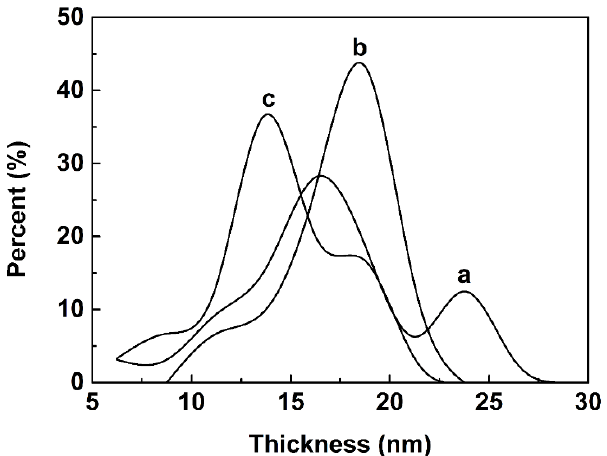
Figure 6. The thickness distribution of the Al(OH) 3 nanosheets: (a) A17H6, (b) A27H6, and (c) A37H6.